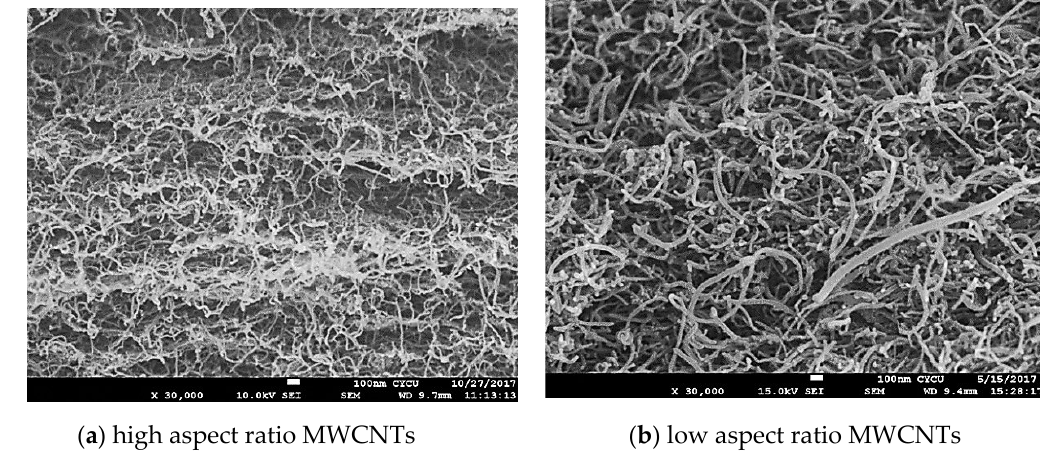
Figure 6. Cross section of buckypaper: ( a ) buckypaper composed of high aspect ratio MWCNTs and ( b ) buckypaper composed of low aspect ratio MWCNTs.